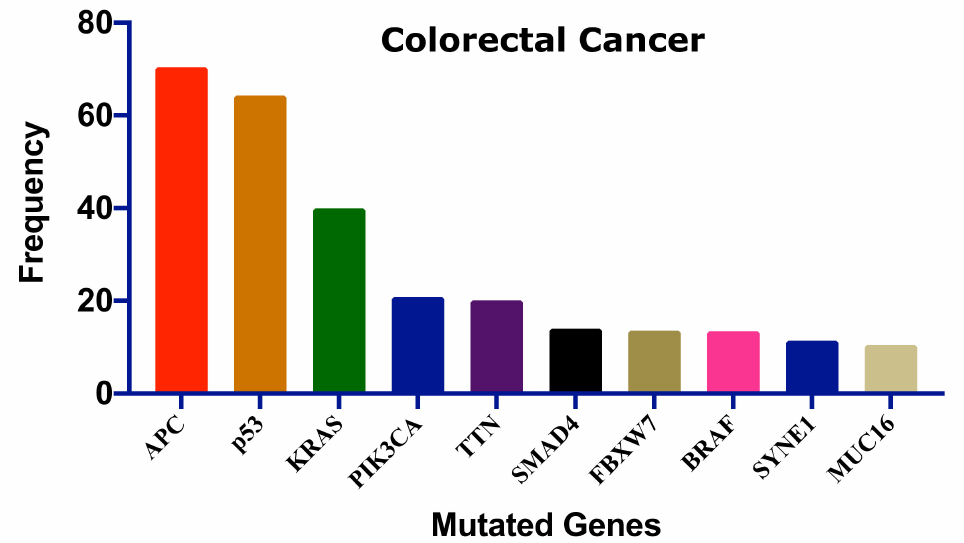
Figure 2. The ten most frequent mutations in colorectal cancer. This frequency distribution was calculated based on the cBioPortal data on 2322 CRC patients [46]. Adenomatous polyposis coli: APC, Tumor protein p53: p53, Kirsten rat sarcoma: KRAS, Phosphatidylinositol-4,5-Bisphosphate 3-Kinase catalytic subunit alpha: PIK3CA, Titin: TTN, SMAD family member 4: SMAD4, F-Box and WD repeat domain containing 7: FBXW7, B-Raf proto-oncogene: BRAF, Spectrin repeats containing nuclear envelope protein 1: SYNE1, Mucin 16: